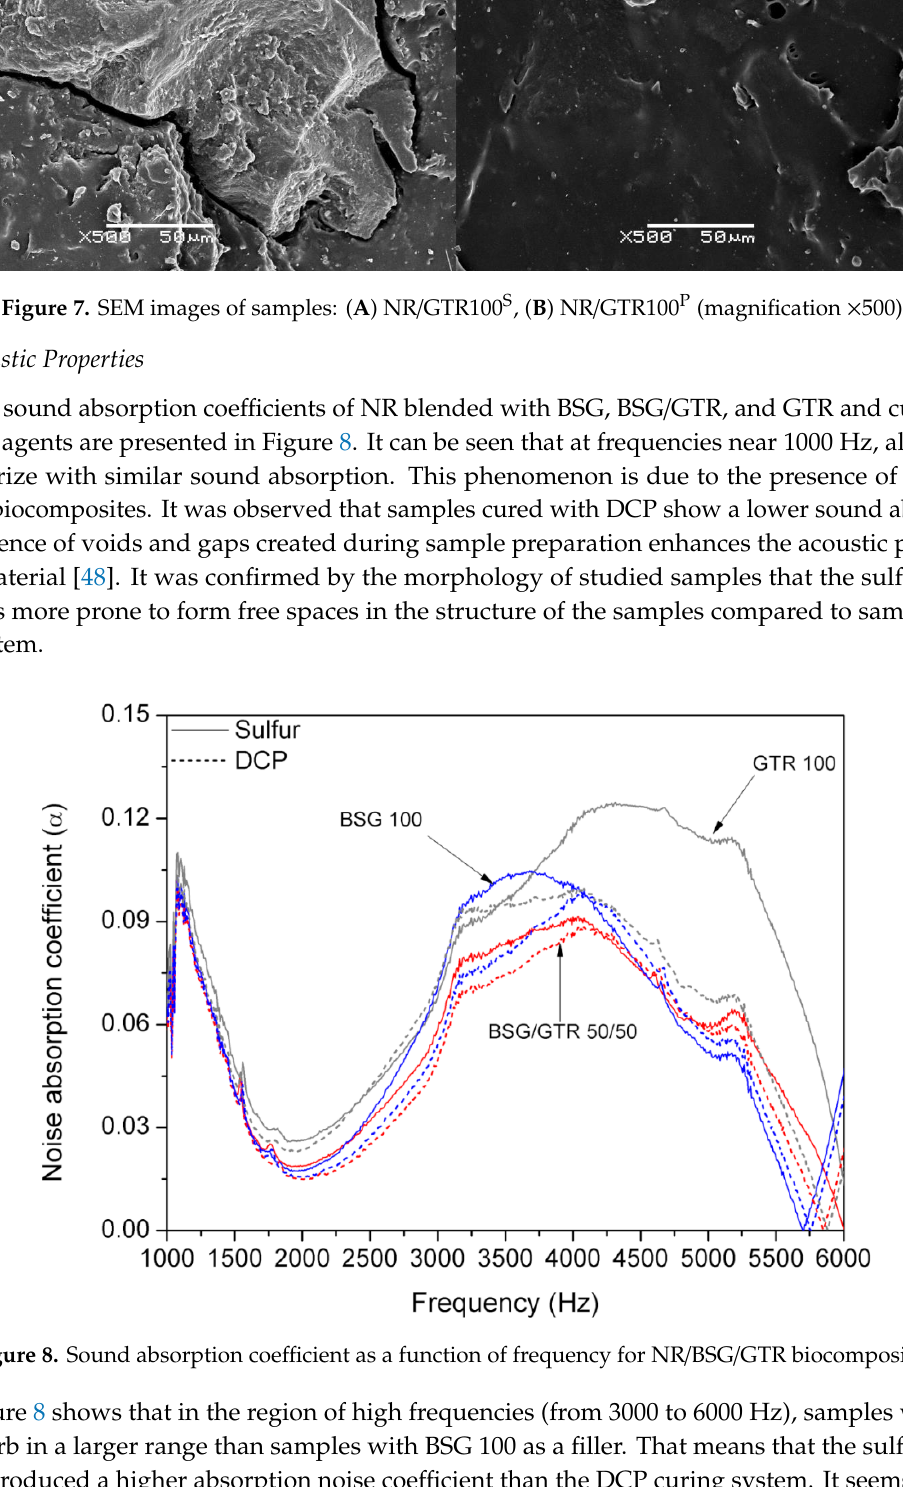
Figure 6. SEM images of samples: ( A1 ) NR/BSG100 S , ( A2 ) NR/BSG/GTR50/50 S , ( A3 ) NR/GTR100 S , ( B1 )